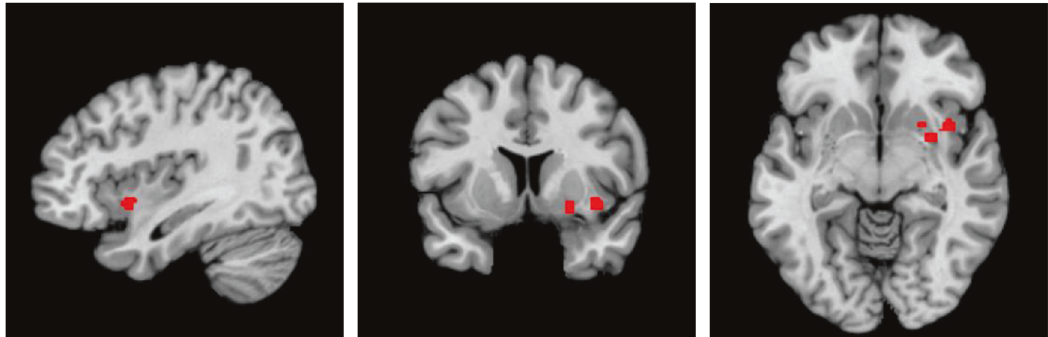
Fig. 3 The result of the sensitivity analysis of voxel-based morphometry studies showing the location of the cluster of signi fi cant grey matter volume reduction in the left hemisphere, centred in the claustrum and also including the putamen and insula, in hallucinators compared to non-hallucinators. The location of the signi fi cant cluster, in sagittal (left), coronal (middle) and axial (right) planes, are highlighted in